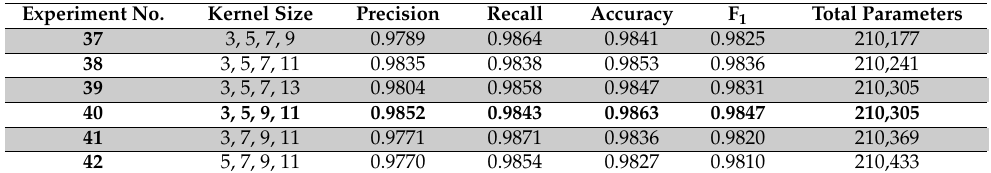
Table 10. Classification performance of the model for four scales with different kernel sizes.